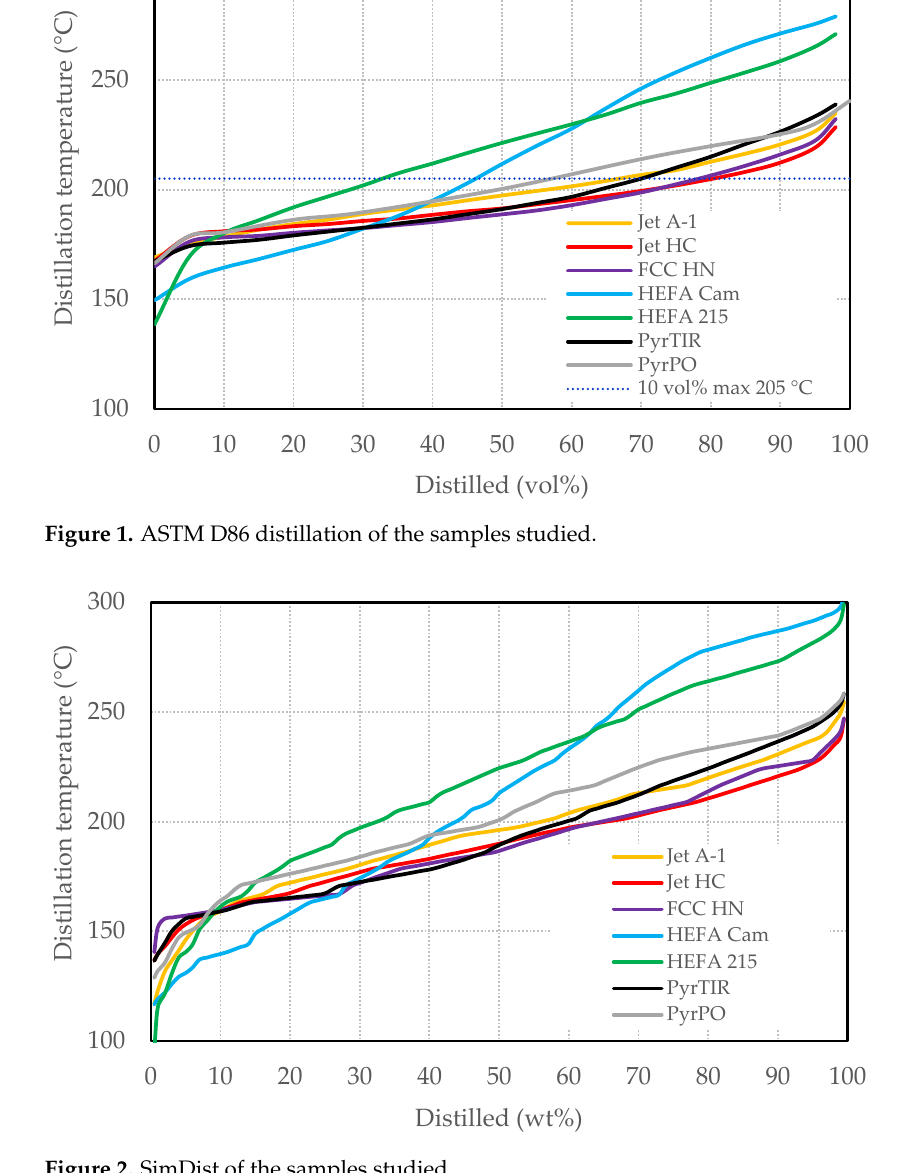
Figure 1. ASTM D86 distillation of the samples studied.